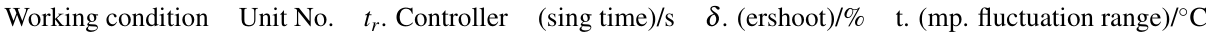
Table 6 Comparison of performance indexes of control